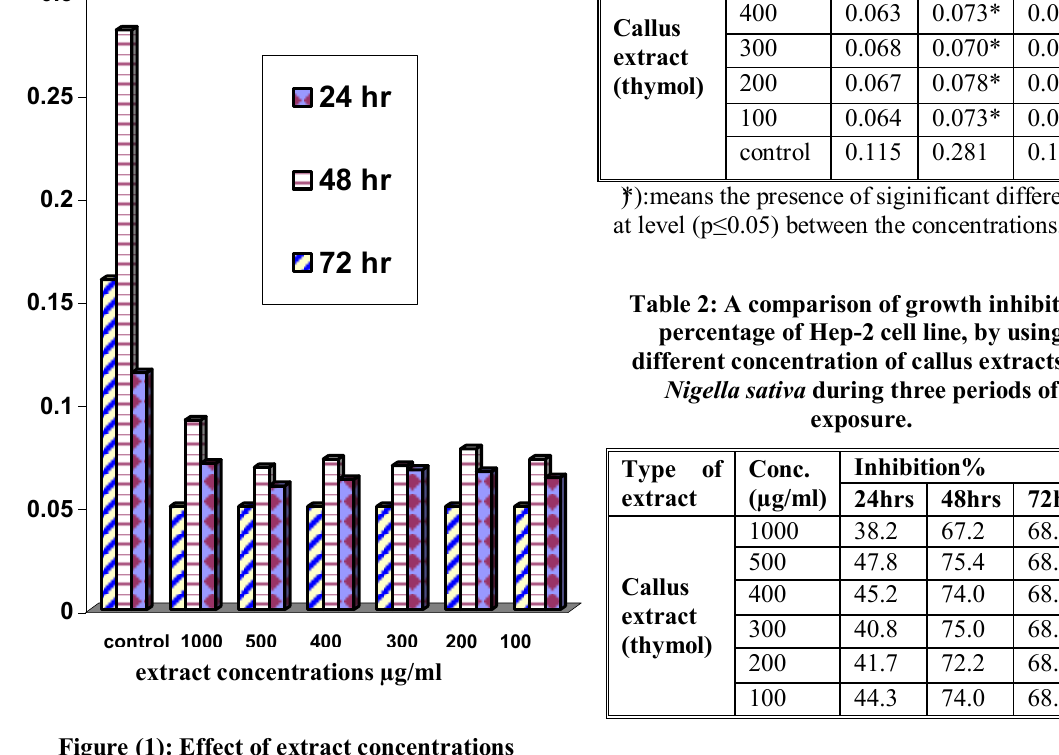
Figure (1): Effect of extract concentrations on the growth of Hep-2 cell line during different exposure preiod.